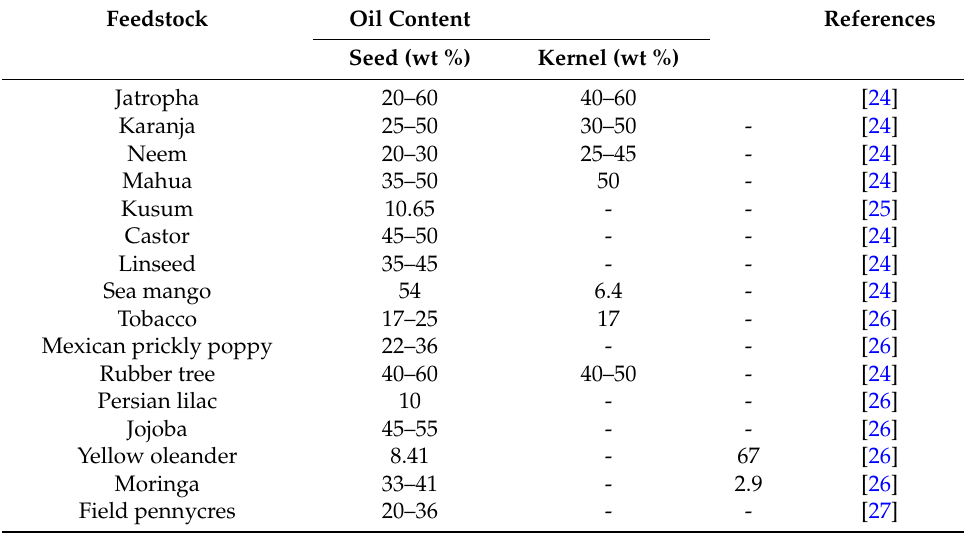
Table 3. Oil content from non-edible